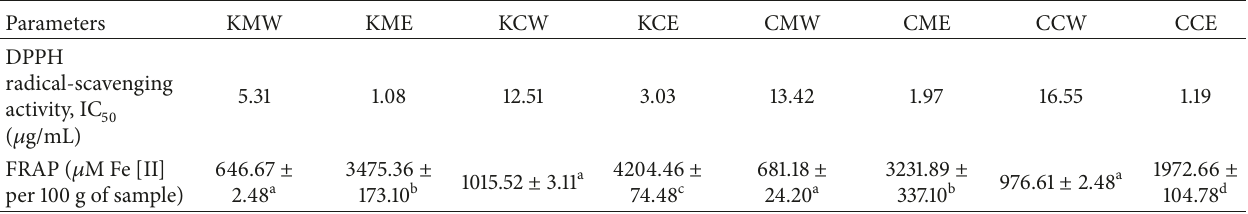
Table 4: FRAP and IC 50 of DPPH values of turmeric varieties (mura and chora) collected from the Khulna and Chittagong divisions.